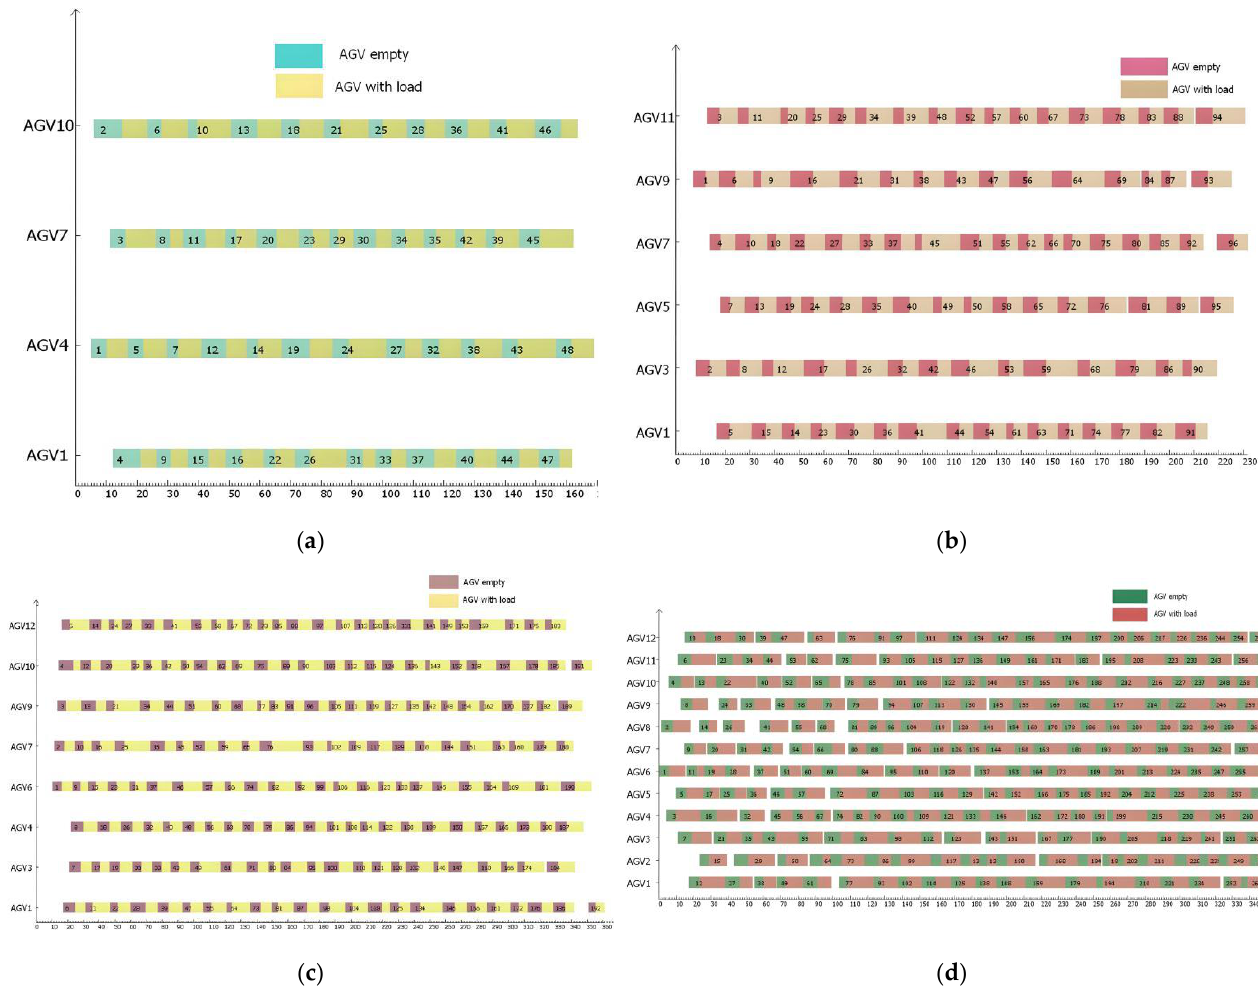
Figure 8. AGV scheduling Gantt chart. ( a ) 48 × 4, ( b ) 96 × 6, ( c ) 192 × 8, ( d ) 384 × 12.